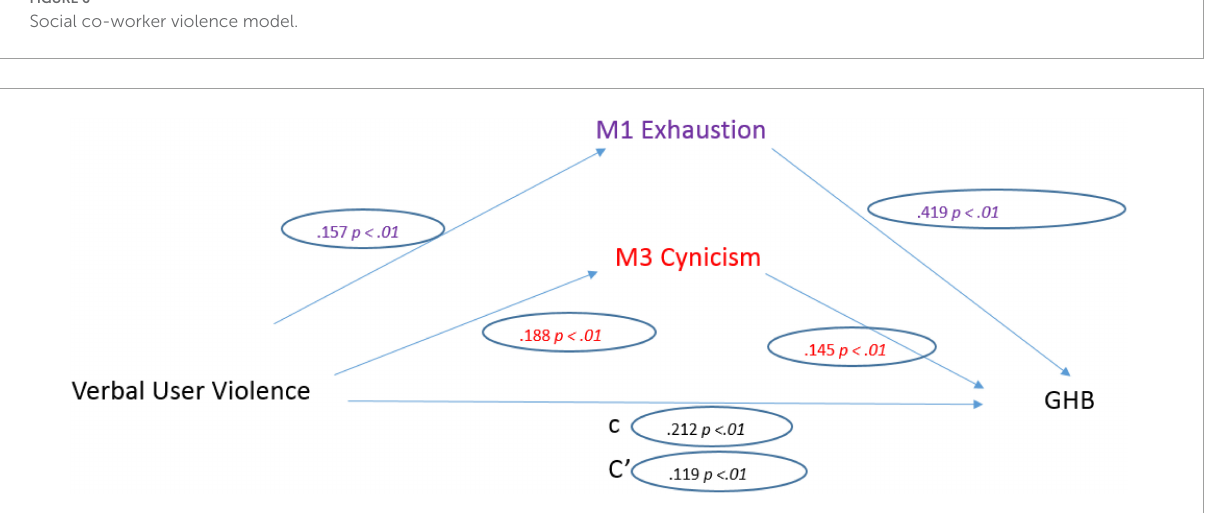
FIGURE6 Social co-worker violence model.